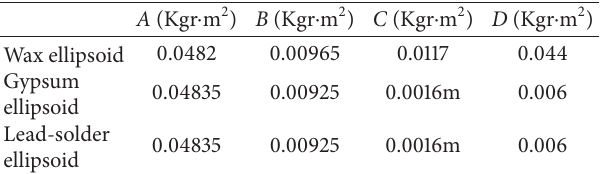
Table 2: Mass moments of inertia were calculated for each